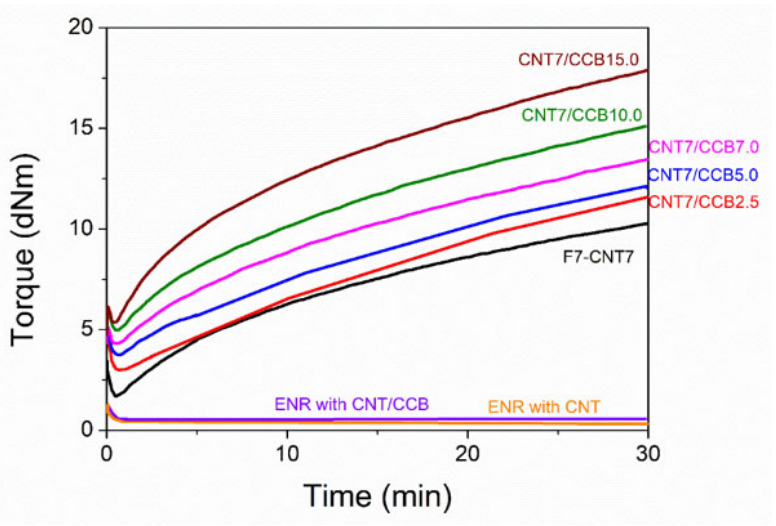
Figure 2. Cure curves of ENR filled with CNTs and CNT–CCB, together with ENR–FeCl 3 filled with 7 phr of CNT (F7-CNT7) and with 7 phr CNT and various CCB loadings at 2.5, 5.0, 7.0, 10.0 and 15.0 (i.e., CNT7/CCB2.5, CNT7/CCB5.0, CNT7/CCB7.0, CNT7/CCB10.0 and CNT7/CCB15.0).